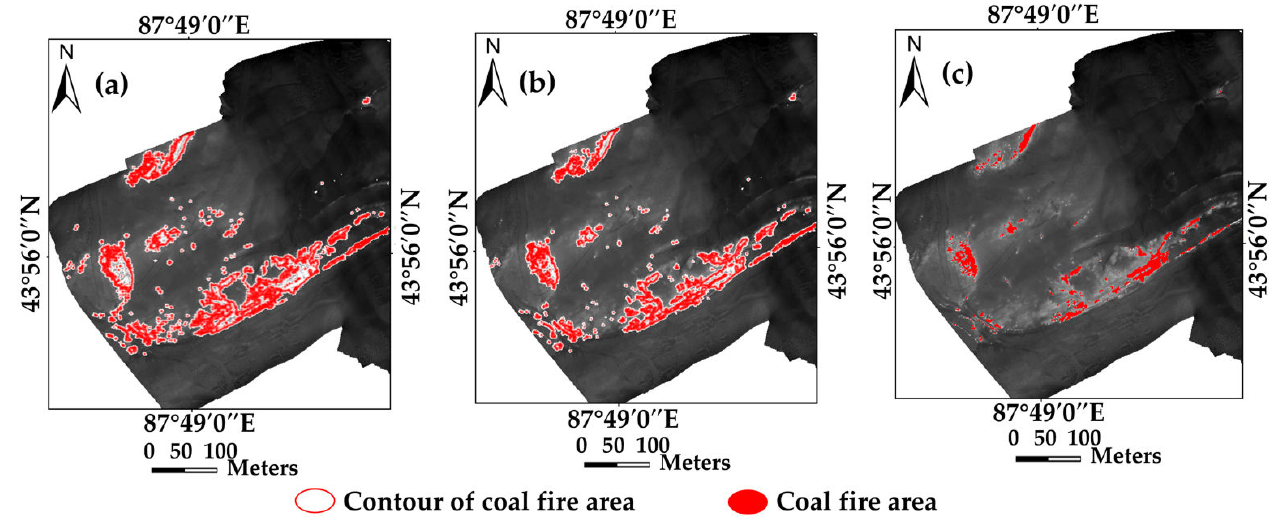
Figure 9. Process of extracting coal fire areas from UAV data: ( a ) 20 iterations, ( b ) 48 iterations, and ( c ) final coal fire results.